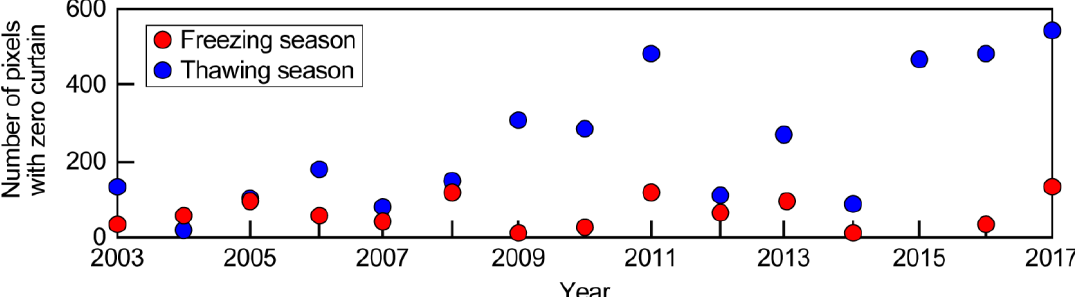
Figure 5. The number of pixels with zero curtain from 2003 to 2017. Out of the 3393 pixels analyzed for the study area (87 × 39 grid) the number of pixels with zero curtain during the thawing seasons have increased over time, while the values for the freezing seasons have remained approximately constant. Note the exception in 2015, for which the number of pixels with zero curtain during freeze-up was not plotted due to an anomalously high number of zero curtain pixels (1260).